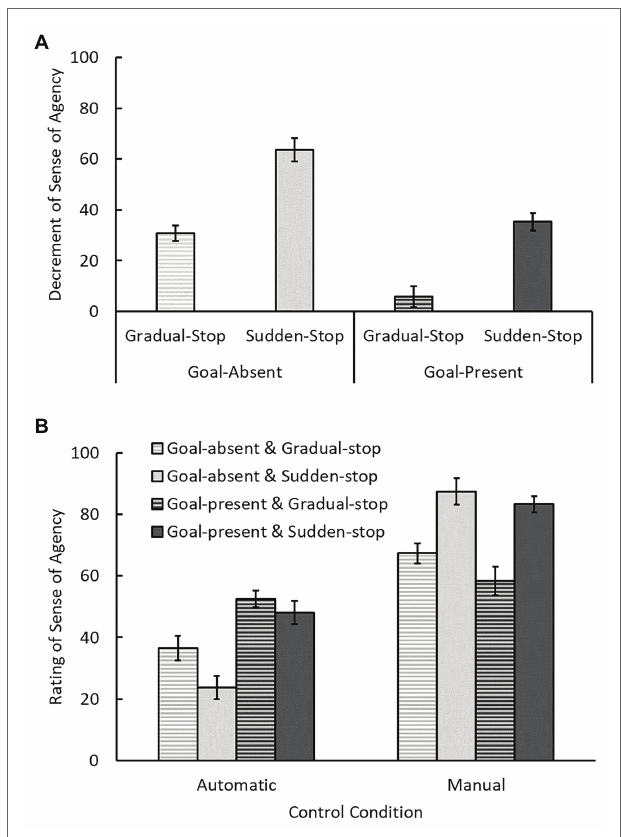
FIGURE 2 | Results of the experiment. (A) Sense of agency (SoA) decrements: differences in SoA between manual and automatic control trials. (B) Subjective ratings of SoA on manual and automatic control trials. Error bars indicate 95% confidence